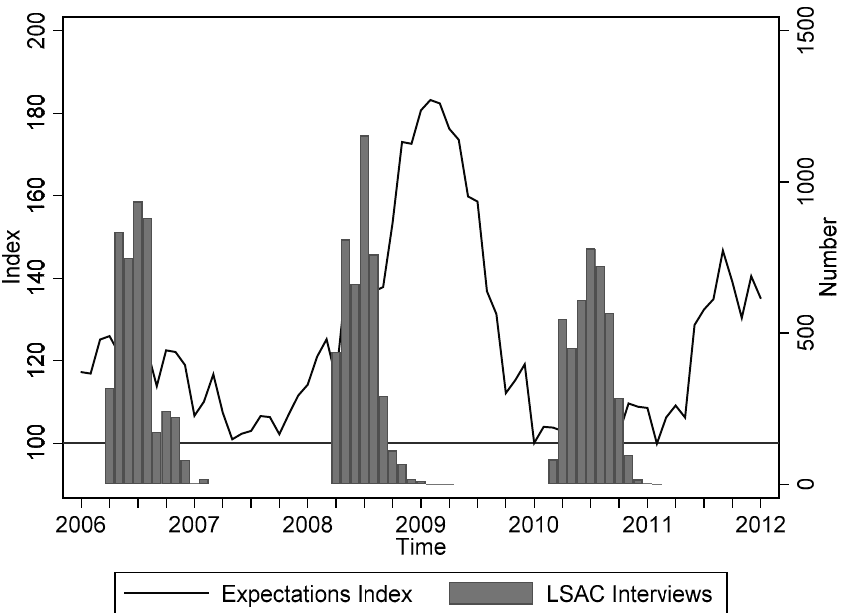
Figure A1. National unemployment expectations index (UEI) and the LSAC interviews, from 2006 Figure B1. National unemployment expectations index (UEI) and the LSAC interviews, to from 2006 to 2012.